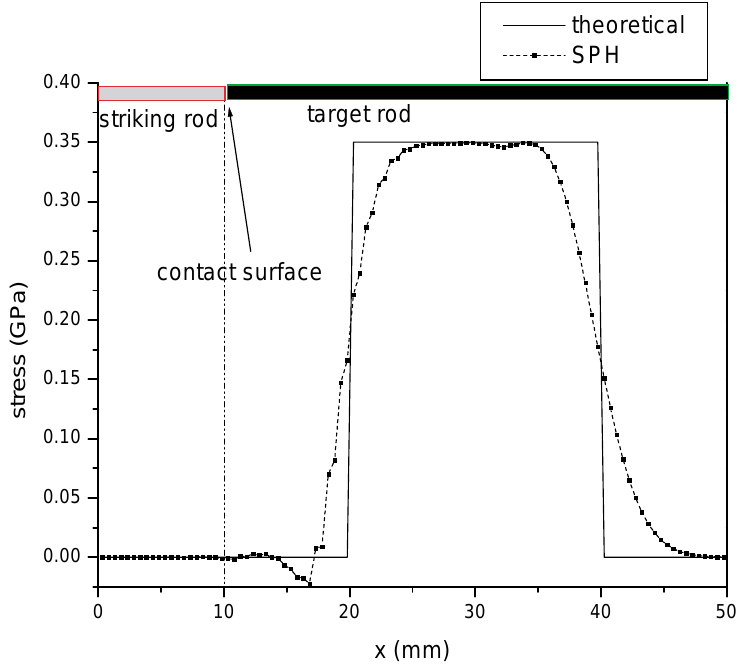
Fig. 1. Stress distribution at time 7.7 µ s for the copper bar impact (Case 1).